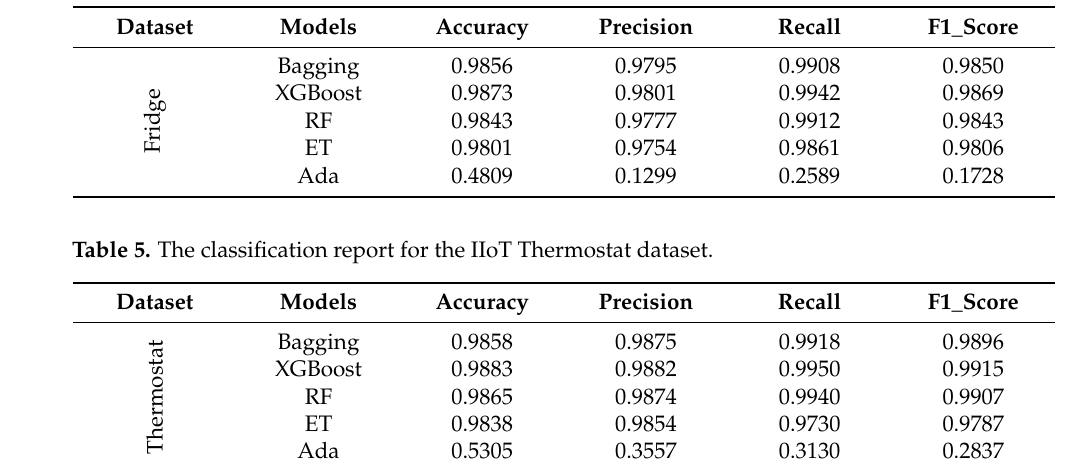
Table 4. The classification report for the IIoT Fridge sensor device dataset.